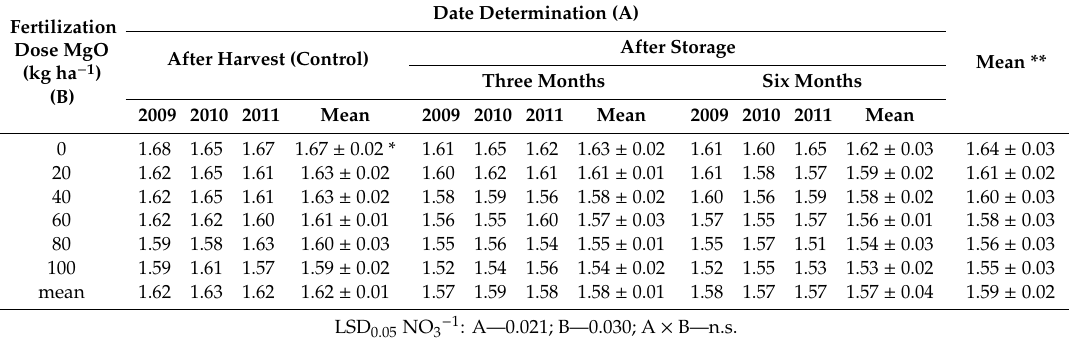
Table 4. The nitrite contents in potato tubers (mg kg −1 FM0 depending on the Mg fertilisation and date of study.